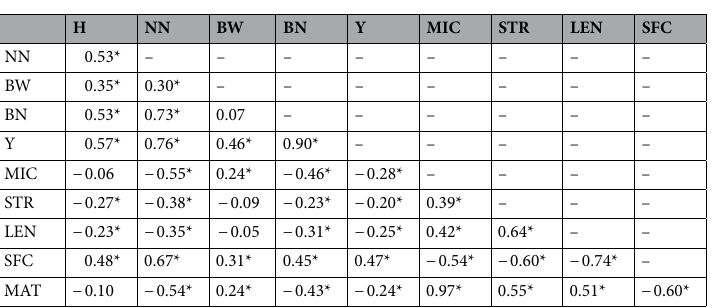
Table 2. Pearson correlation coefficient for plant height (H), node number (NN), boll weight (BW), boll number (BN), yield (Y), micronaire (MIC), fiber strength (STR), length (LEN), short fiber content (SFC) and